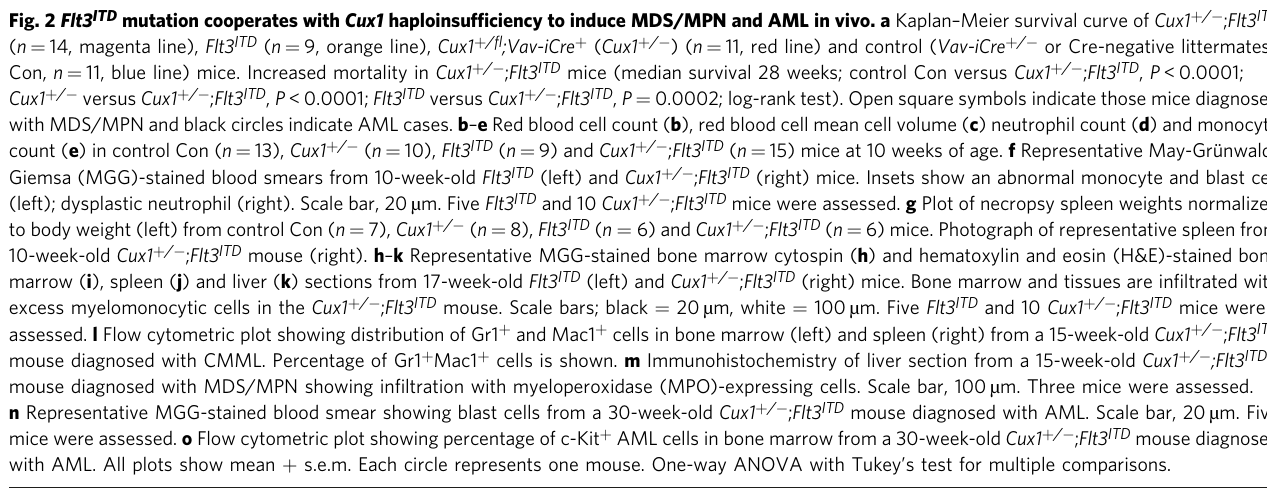
Fig. 2 Flt3 ITD mutation cooperates with Cux1 haploinsuf fi ciency to induce MDS/MPN and AML in vivo. a Kaplan – Meier survival curve of Cux1 + / − ; Flt3 ITD ( n = 14, magenta line), Flt3 ITD ( n = 9, orange line), Cux1 + / fl ;Vav-iCre + ( Cux1 + / − ) ( n = 11, red line) and control ( Vav-iCre + / − or Cre-negative littermates, Con, n = 11, blue line) mice. Increased mortality in Cux1 + / − ; Flt3 ITD mice (median survival 28 weeks; control Con versus Cux1 + / − ; Flt3 ITD , P < 0.0001; Cux1 + / − versus Cux1 + / − ; Flt3 ITD , P < 0.0001; Flt3 ITD versus Cux1 + / − ; Flt3 ITD , P = 0.0002; log-rank test). Open square symbols indicate those mice diagnosed with MDS/MPN and black circles indicate AML cases. b – e Red blood cell count ( b ), red blood cell mean cell volume ( c ) neutrophil count ( d ) and monocyte count ( e ) in control Con ( n = 13), Cux1 + / − ( n = 10), Flt3 ITD ( n = 9) and Cux1 + / − ; Flt3 ITD ( n = 15) mice at 10 weeks of age. f Representative